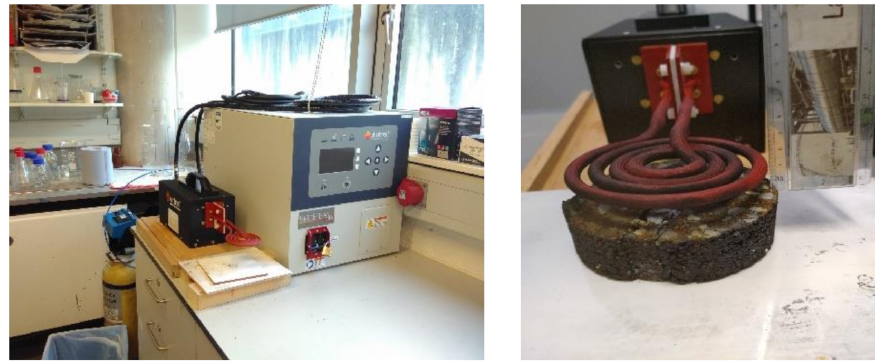
Figure 2. Ambrell Ekoheat 10 kW induction machine—laboratory induction